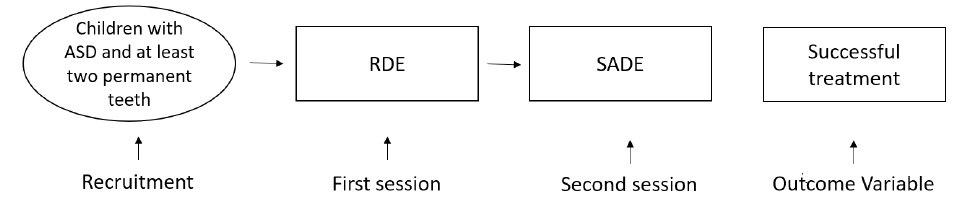
Figure 1. Overview of study design. Regular dental environment (RDE); sensory-adapted dental environment (SADE).